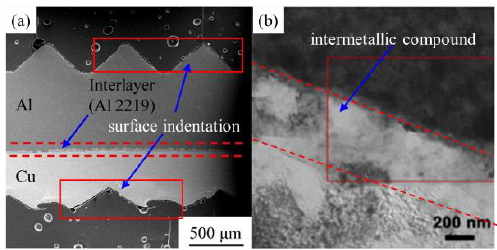
Figure 1. ( a ) Surface indentation of ultrasonic welding (reproduced from [9], with permission of Elsevier 2020); ( b ) Intermetallic compound layer with friction stir welding (reproduced from [15], with permission of Elsevier 2015).